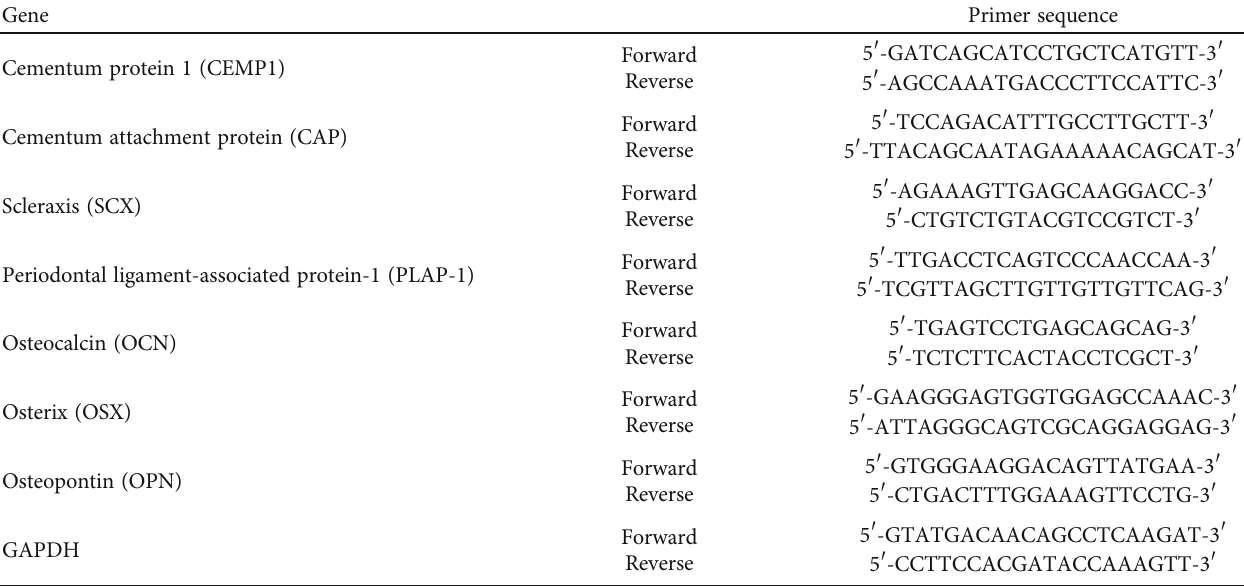
Table 2: Primers used for the quantitative real-time-PCR